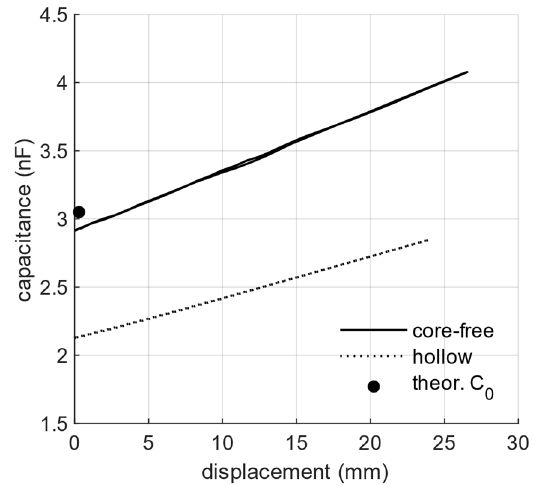
Figure 13. Measured capacitance for both RDEAs and theoretical initial capacitance C 0 based on (4).